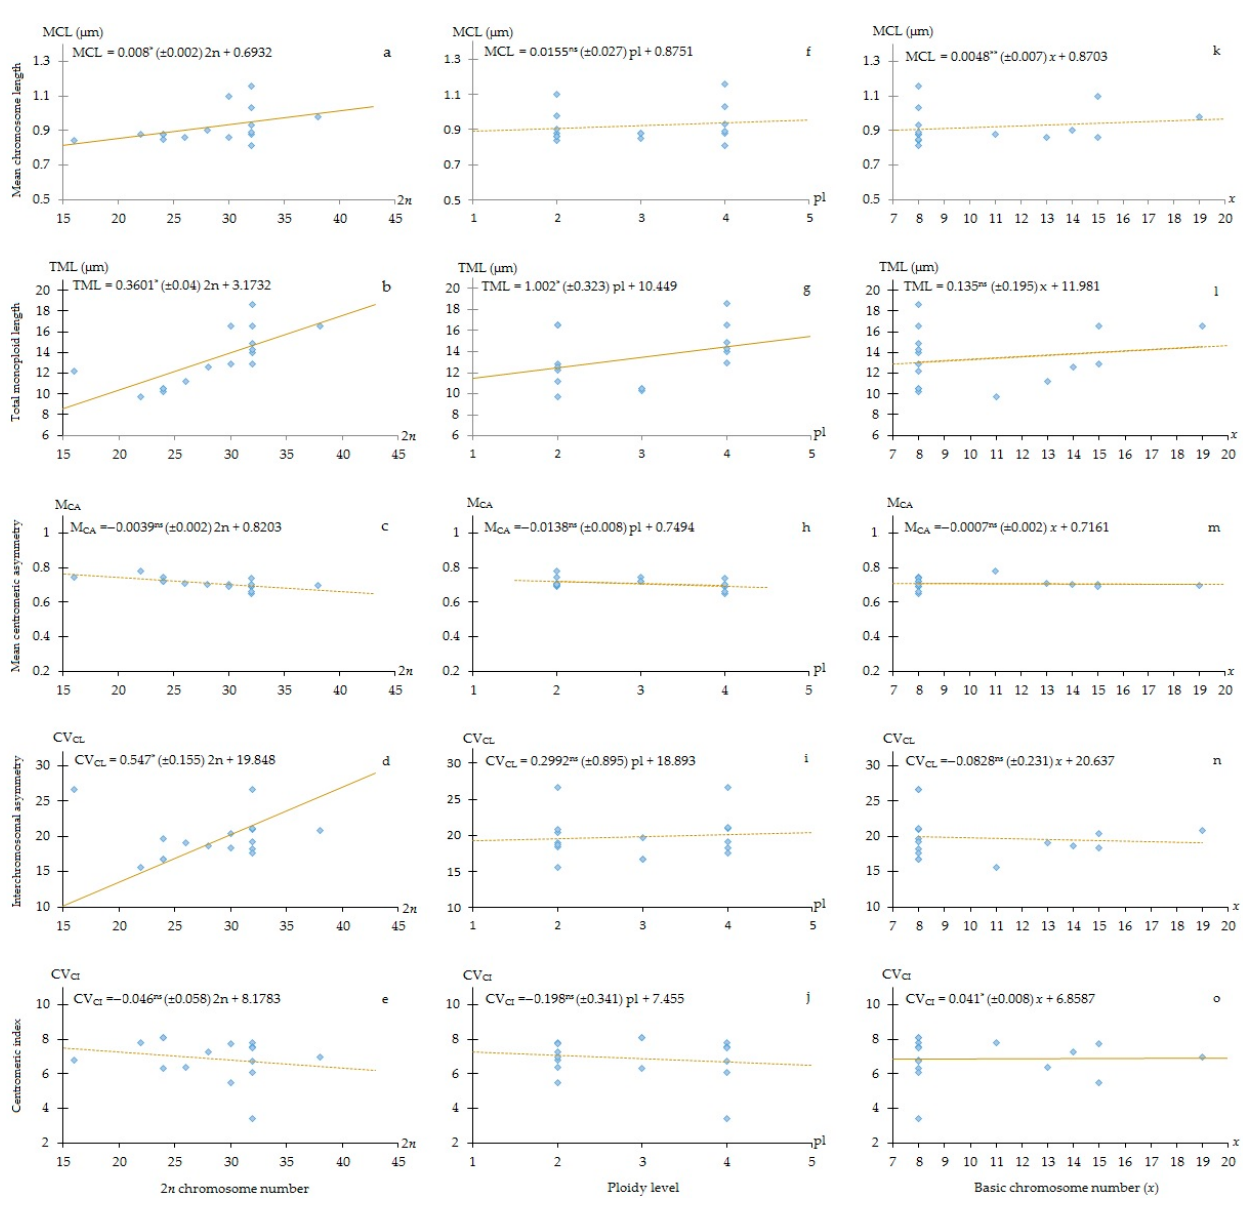
Figure 3. Regression analysis of chromosome data (ploidy level, 2 n chromosome number, basic chromosome number ( x )) versus karyological parameters (mean chromosome length (MCL), total length of monoploid chromosome set (TML); interchromosomal asymmetry (CV CL ), centromeric index (CV CI ) and mean centromeric asymmetry (M CA ) in Hypericum perforatum populations. Solid lines in a , b , f show significant linear regression, and dotted lines in the other plots represent not significant correlations. The five significant regression models in a , b , d , g , o had p values < 0.05. a – o : linear regression relationships between dependent and independent